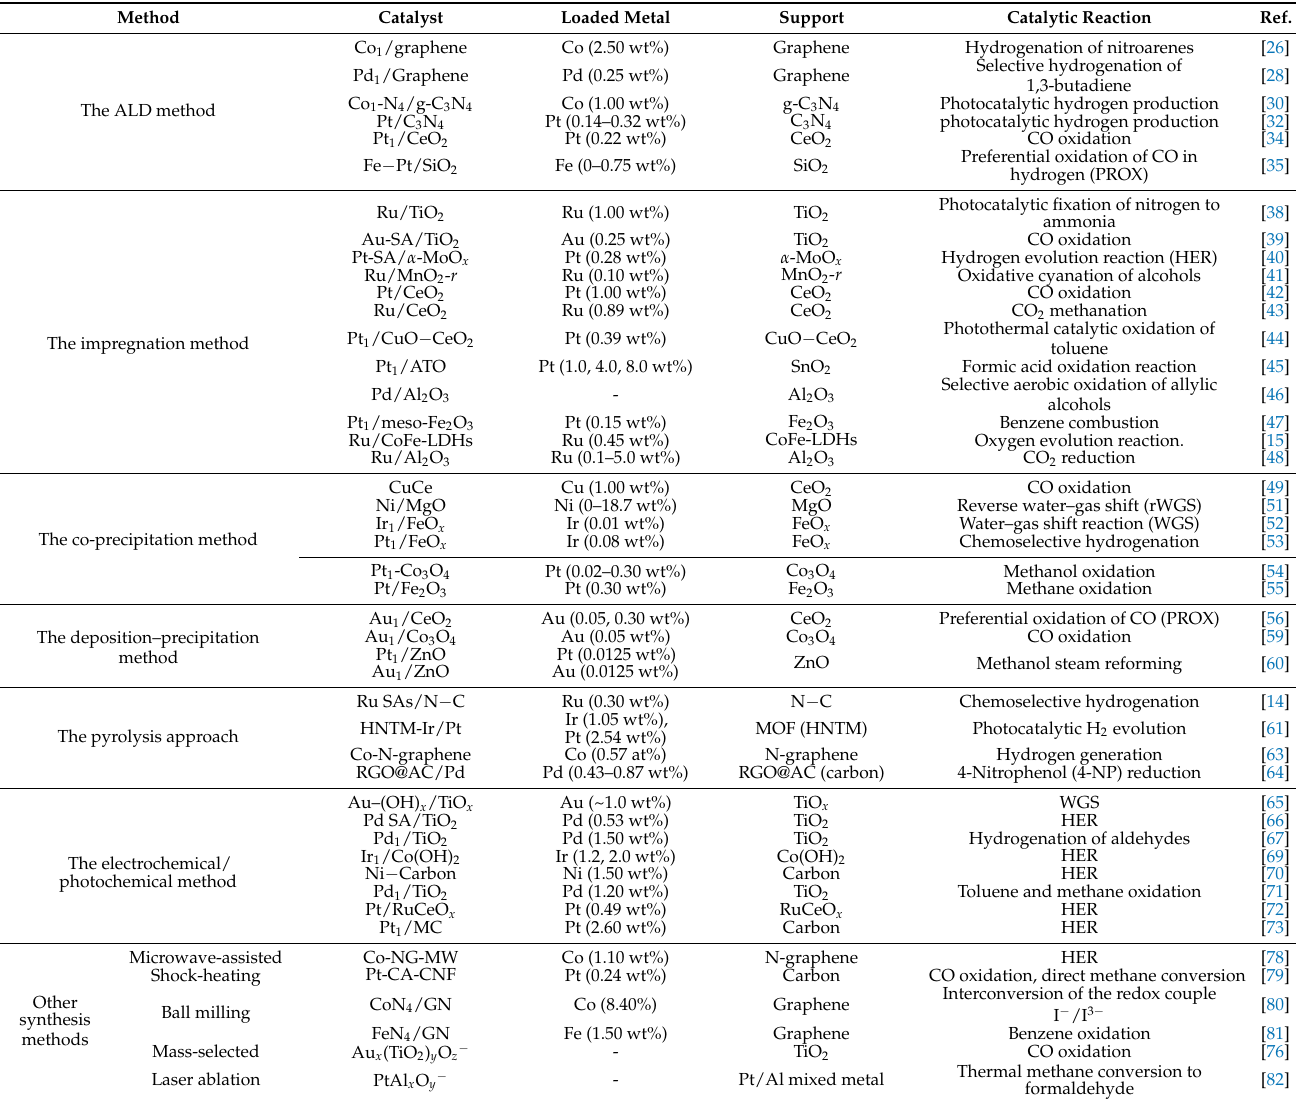
Table 1. The SACs are prepared by the ALD, wet-chemistry, pyrolysis, electrochemical/photochemical, and other synthesis